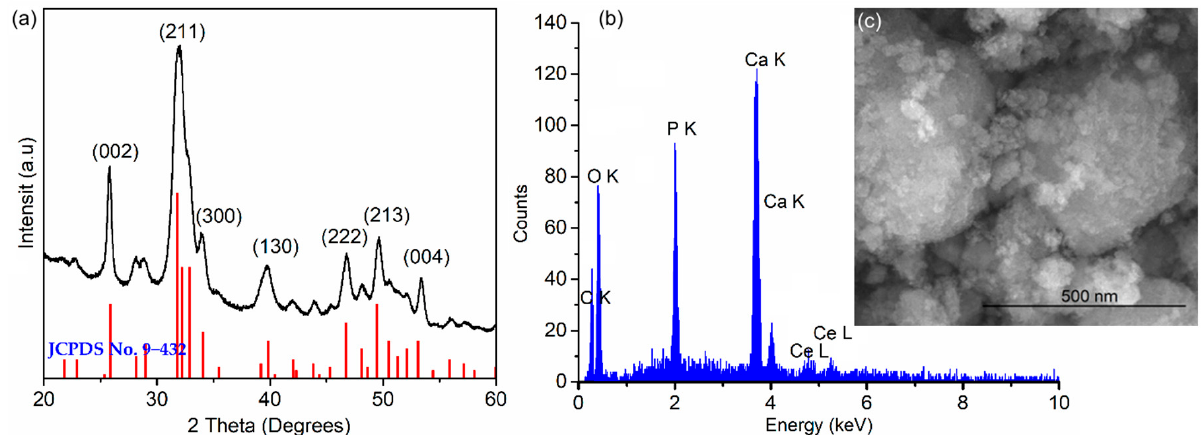
Figure 2. TEM image of 10Ce-HAp.